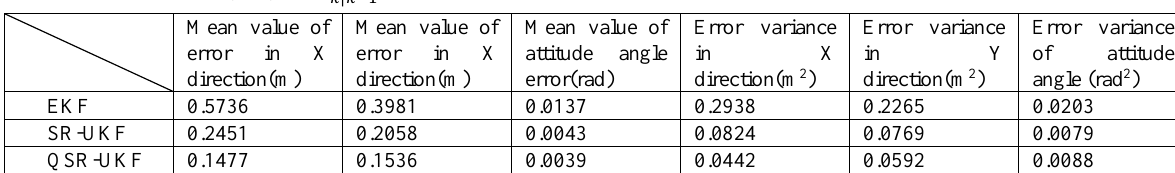
Table 1. performance comparison of the three